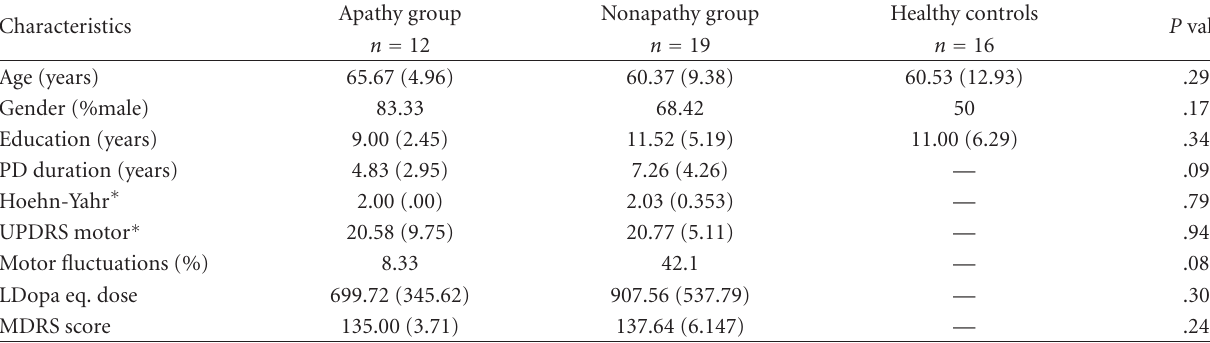
Table 1: Demographic and clinical characteristics of subject groups.